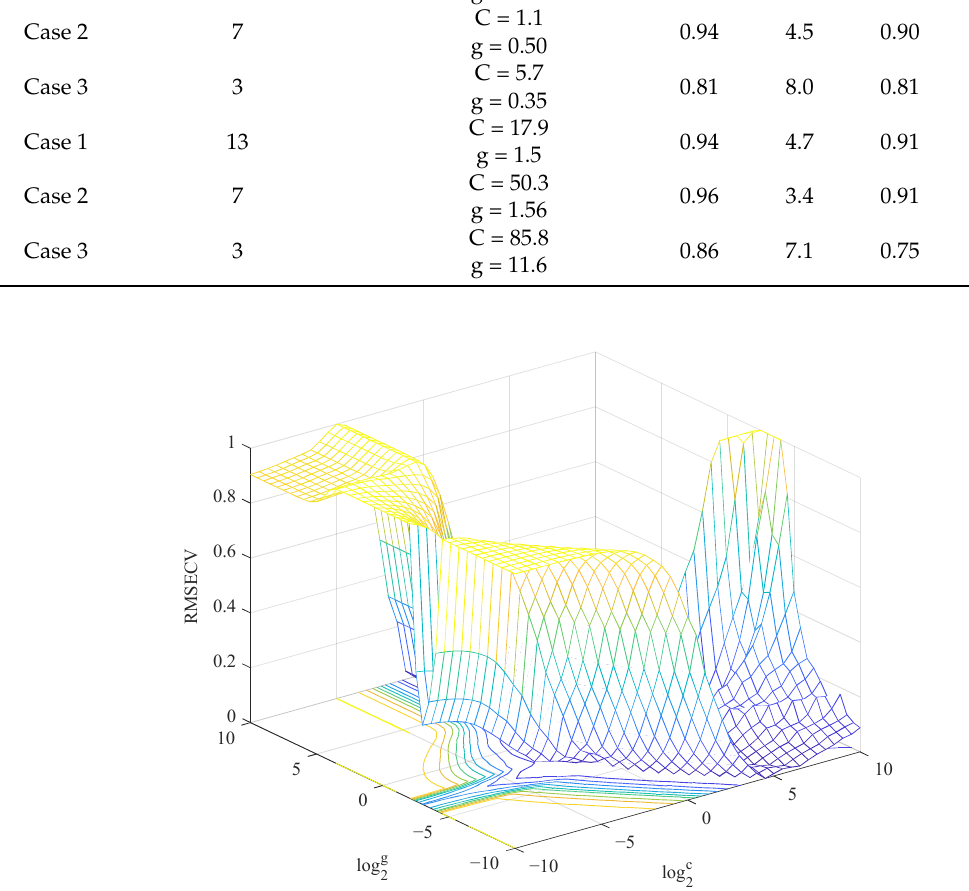
Figure 3. Three-dimensional view of C and g parameter is searched in the SVR using GS method.